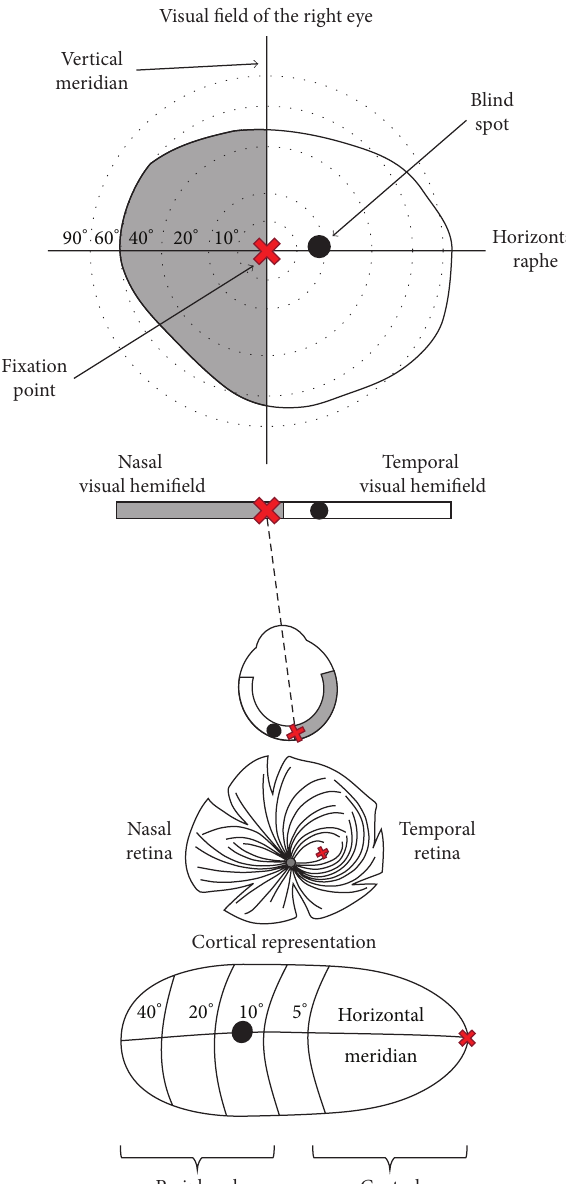
Figure 2: Projection representation of the right visual field. Right eye receives input from nasal visual hemifield (grey) with representation of the central fixation point (red cross) and temporal visual hemifield (white) with blind spot (black dot) located at visual 10 ∘ . The thick irregular black line delineates part of the visual field as seen through the right eye. Retinal representation of the visual field shows position of the central fixation and blind spot. Temporal retina receives input from the nasal visual hemifield (gray) and nasal retina (white). Drawing of the flatmount retina preparation shows optical nerves encircling area centralis with central fixation point (red cross), with all optical fibers and blood vessels leaving the retina via blind spot. In the cortical representation of the visual field, note the magnification of the representation of the central visual field (compromising visual 5 ∘ ) and the relatively small peripheral visual field